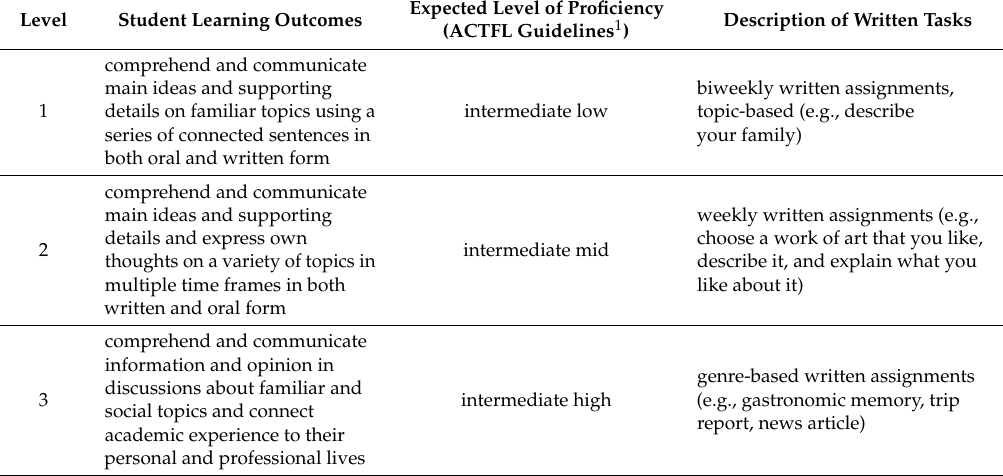
Table 2. Student learning outcomes and expected level of proficiency for each